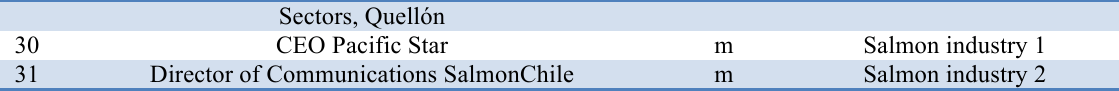
Table A1.3 Actors and Tweeter accounts